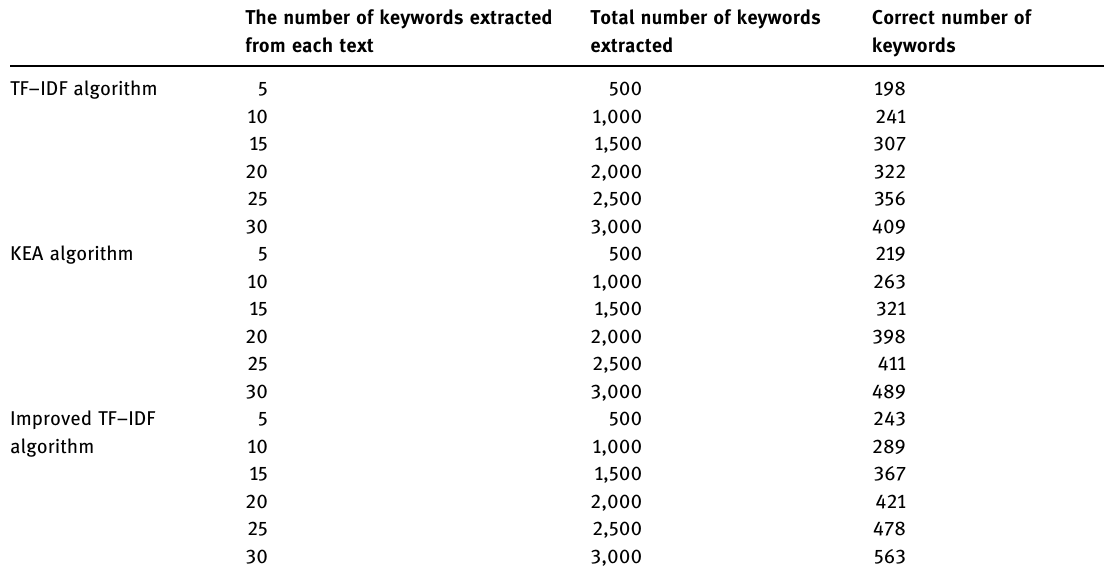
Table 5: Results of keyword extraction under di ff erent